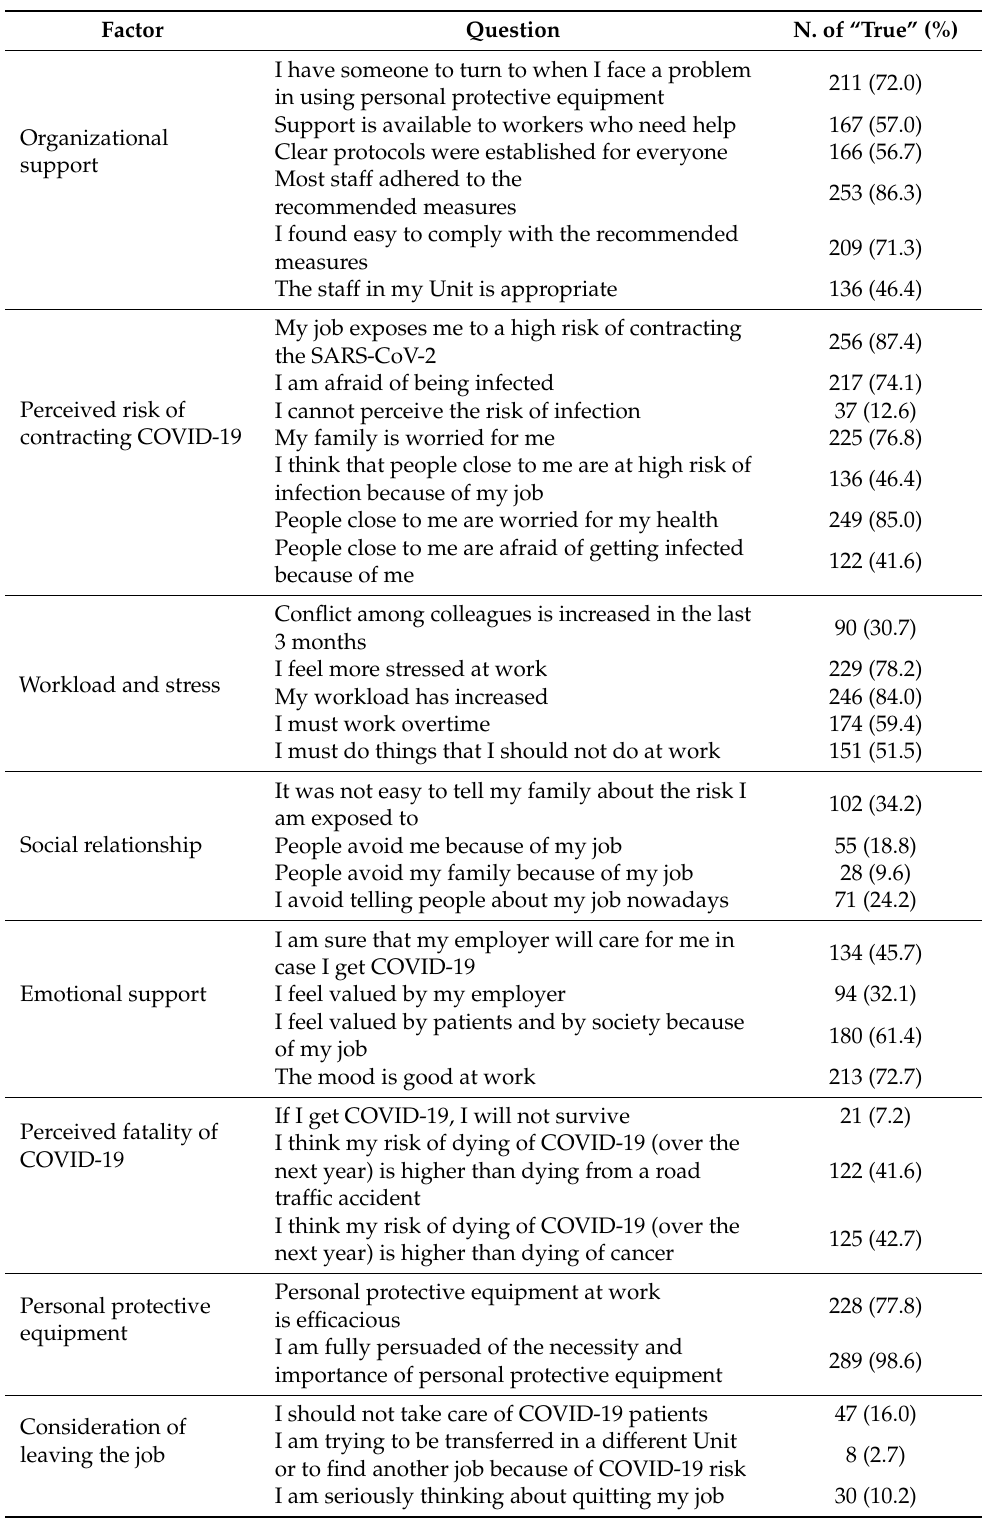
Table 2. Impact of COVID-19 outbreak according to the analyzed working